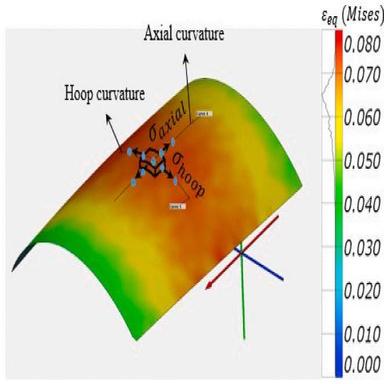
Strains and radii of curvatures are measured on the surface of the bulged tube using DIC.